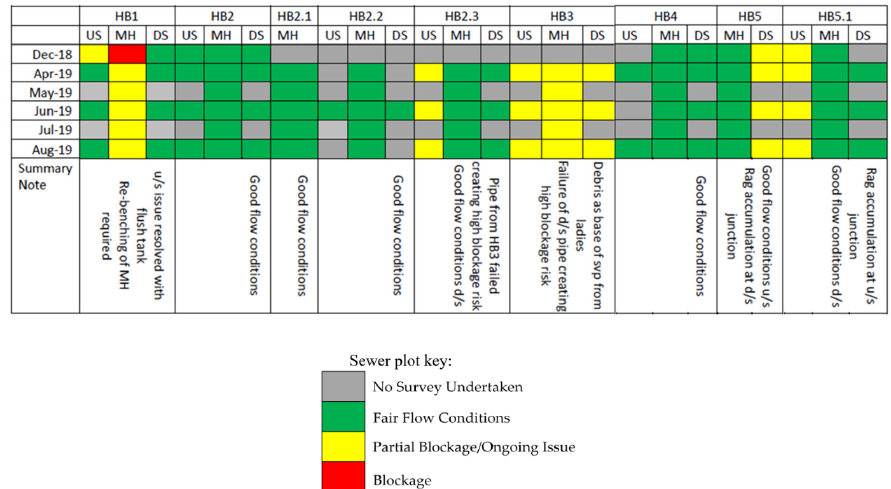
Figure 6. Photograph of Manhole HB 1 from lift and look surveys in December 2018 and April 2019. The image on the left-hand side shows a blockage in the chamber caused by a build-up of rag.